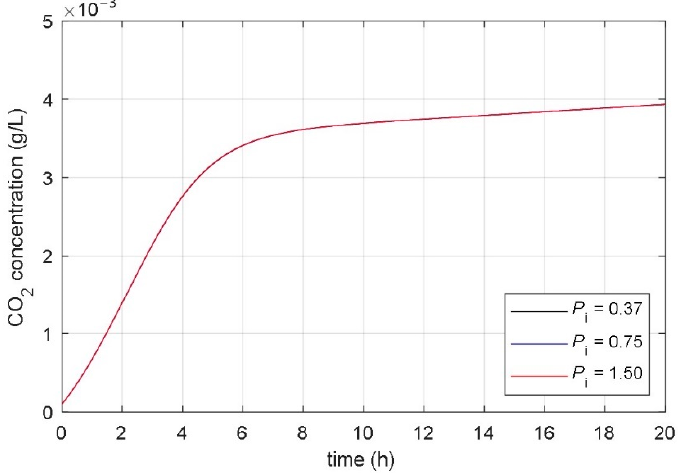
Figure 5. The impact of the product inhibition constant P i on the time course of the CO 2 concentration.